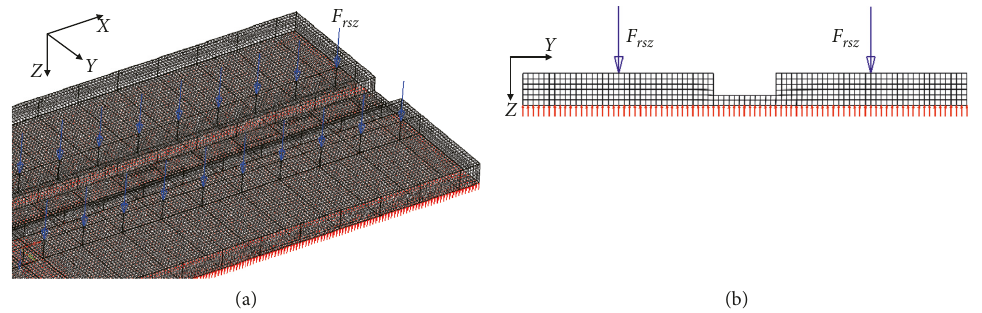
Figure 8: Finite-element model for a monolithic concrete